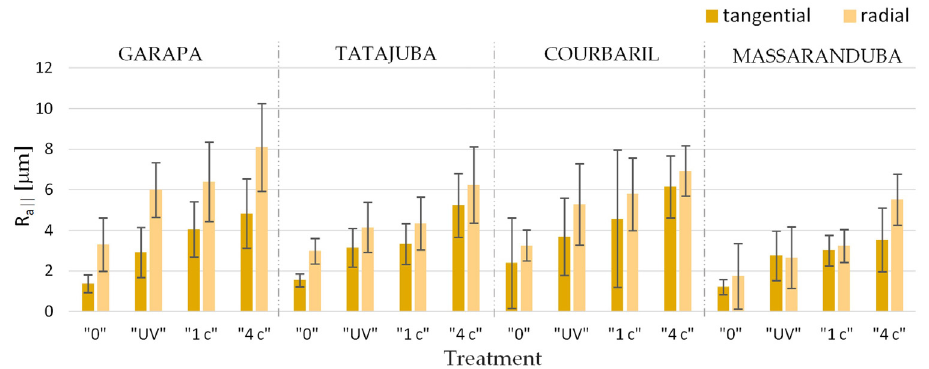
Figure 2. Roughness ( R aII ) along the fibres of tested wood species: “O”—fresh wood, “UV”—after 24 h of UV irradiation, “1 c”—after one cycle of artificial weathering, “4 c”—after four cycles of artificial weathering.